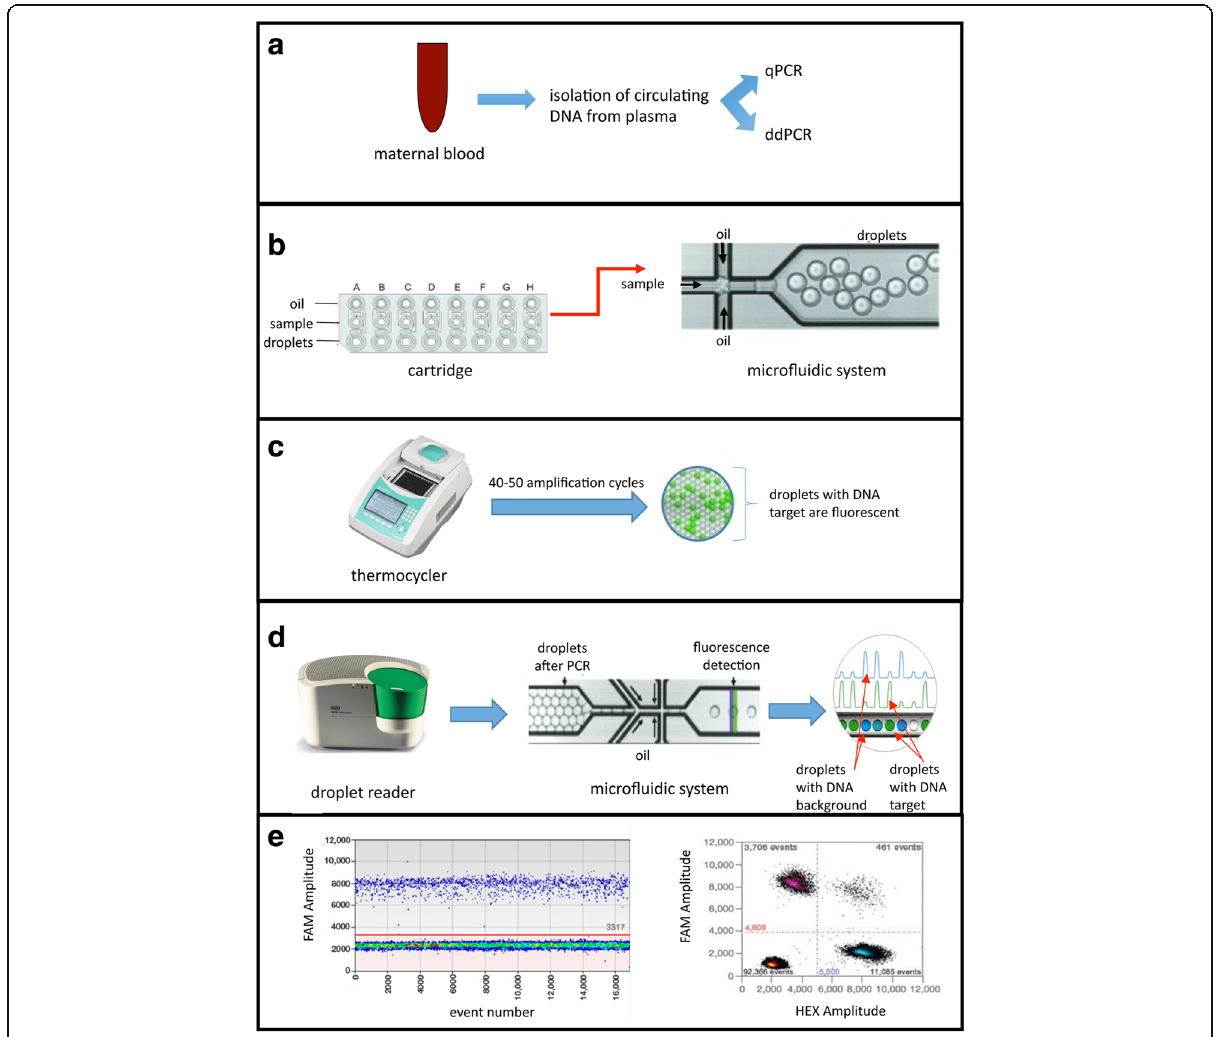
Fig. 1 Experimental strategy. a Isolation of circulating DNA (maternal and fetal) from plasma obtained from pregant women at different gestational ages and analysis of fetal sex by qPCR and ddPCR. b An automated system blends oil samples into a cartridge and generates droplets of nanolitre size by a microfluidic system and vacuum generation. c The emulsion is transferred to the thermocycler for the amplification. The presence of the target template in the droplets will be detected by the fluorescence development. d Detection of fluorescence using the Droplet Reader. The system, after the injection of a reader oil, separates and aligns each droplet, which is analyzed by two lasers to detect fluorescence. e Analysis of the data represented in graphs as the fluorescence (FAM or HEX) relative to each droplet (Event